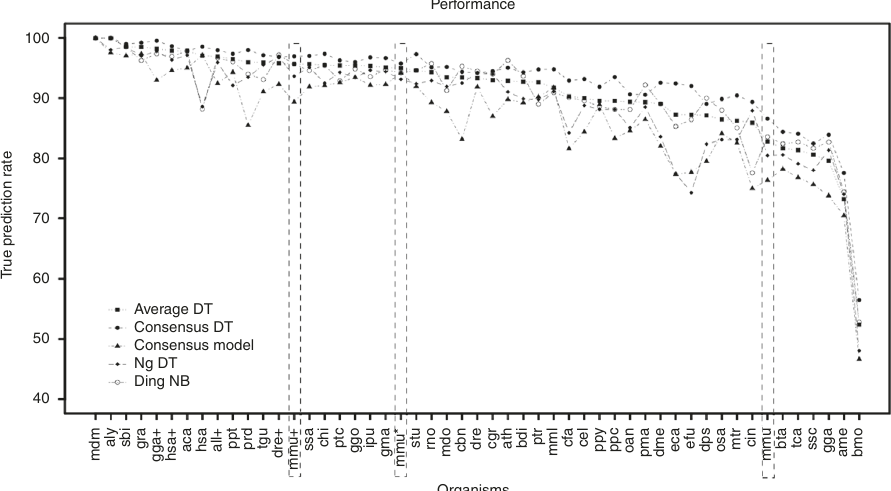
Fig. 2 Generalization performance of izMiR. Line plot showing the true prediction rates ( y axis) of hairpins from different organisms. Mmu* stands for fi ltered mouse hairpins from miRBase based on a minimum RPM value of 100 and mmu refers to all mouse hairpins without fi ltering while mmu + indicates mouse hairpins from MirGeneDB. Only organisms with a minimum of 200 hairpins in miRBase were selected for this plot. Results for all organisms in miRBase are available for download from our web page: http://jlab.iyte.edu.tr/izmir. The lines do not indicate a mathematical relationship and are only added for simplifying visual